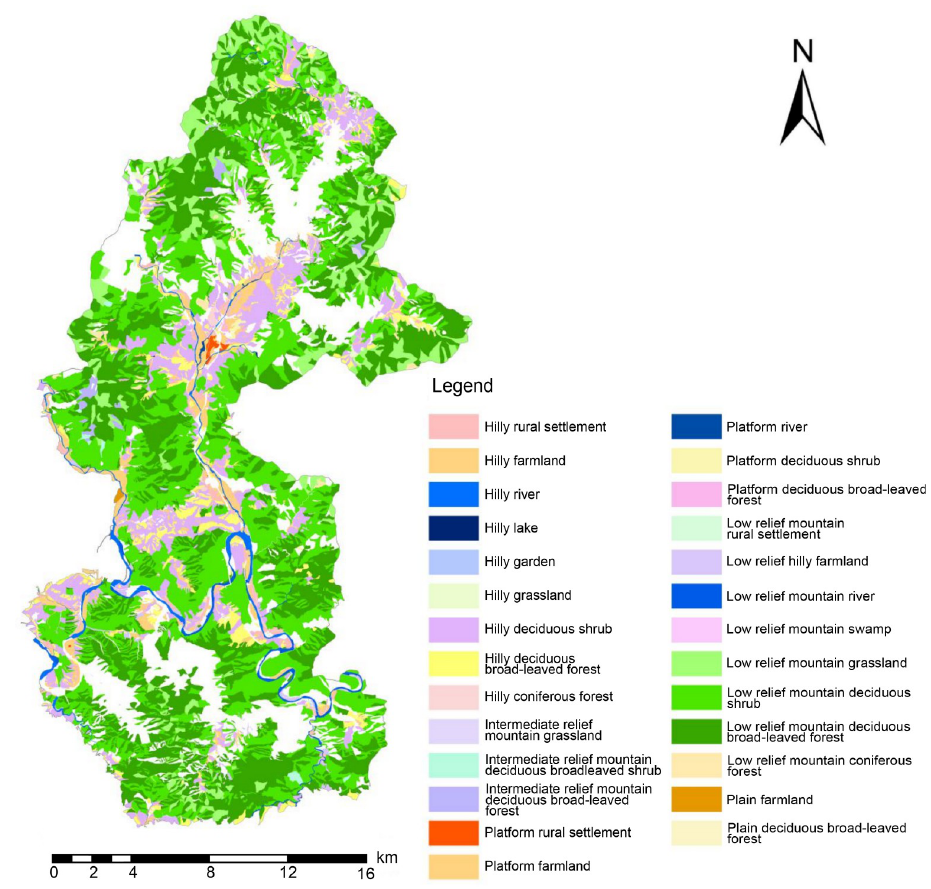
Fig 3. Distribution map of scenic resource groups in non-canyon/river valley areas. (Republished from [https:// directory.eoportal.org/web/eoportal/satellite-missions/g/gaofen-2] under a CC BY license, with permission